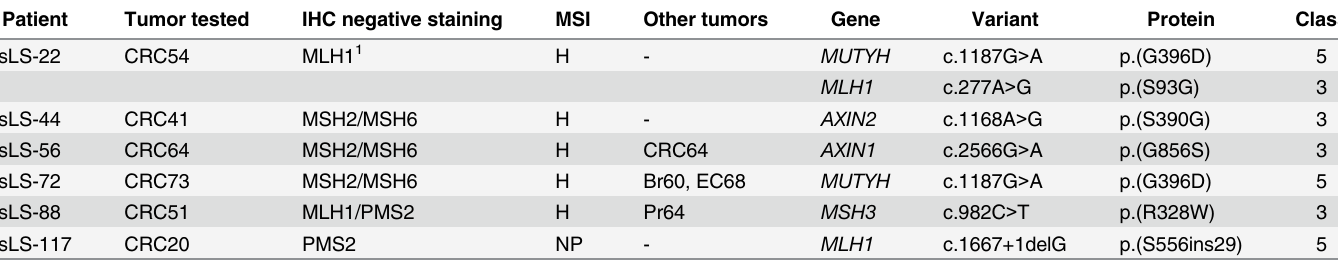
Table 3. Patients with germline coding VUS or germline pathogenic